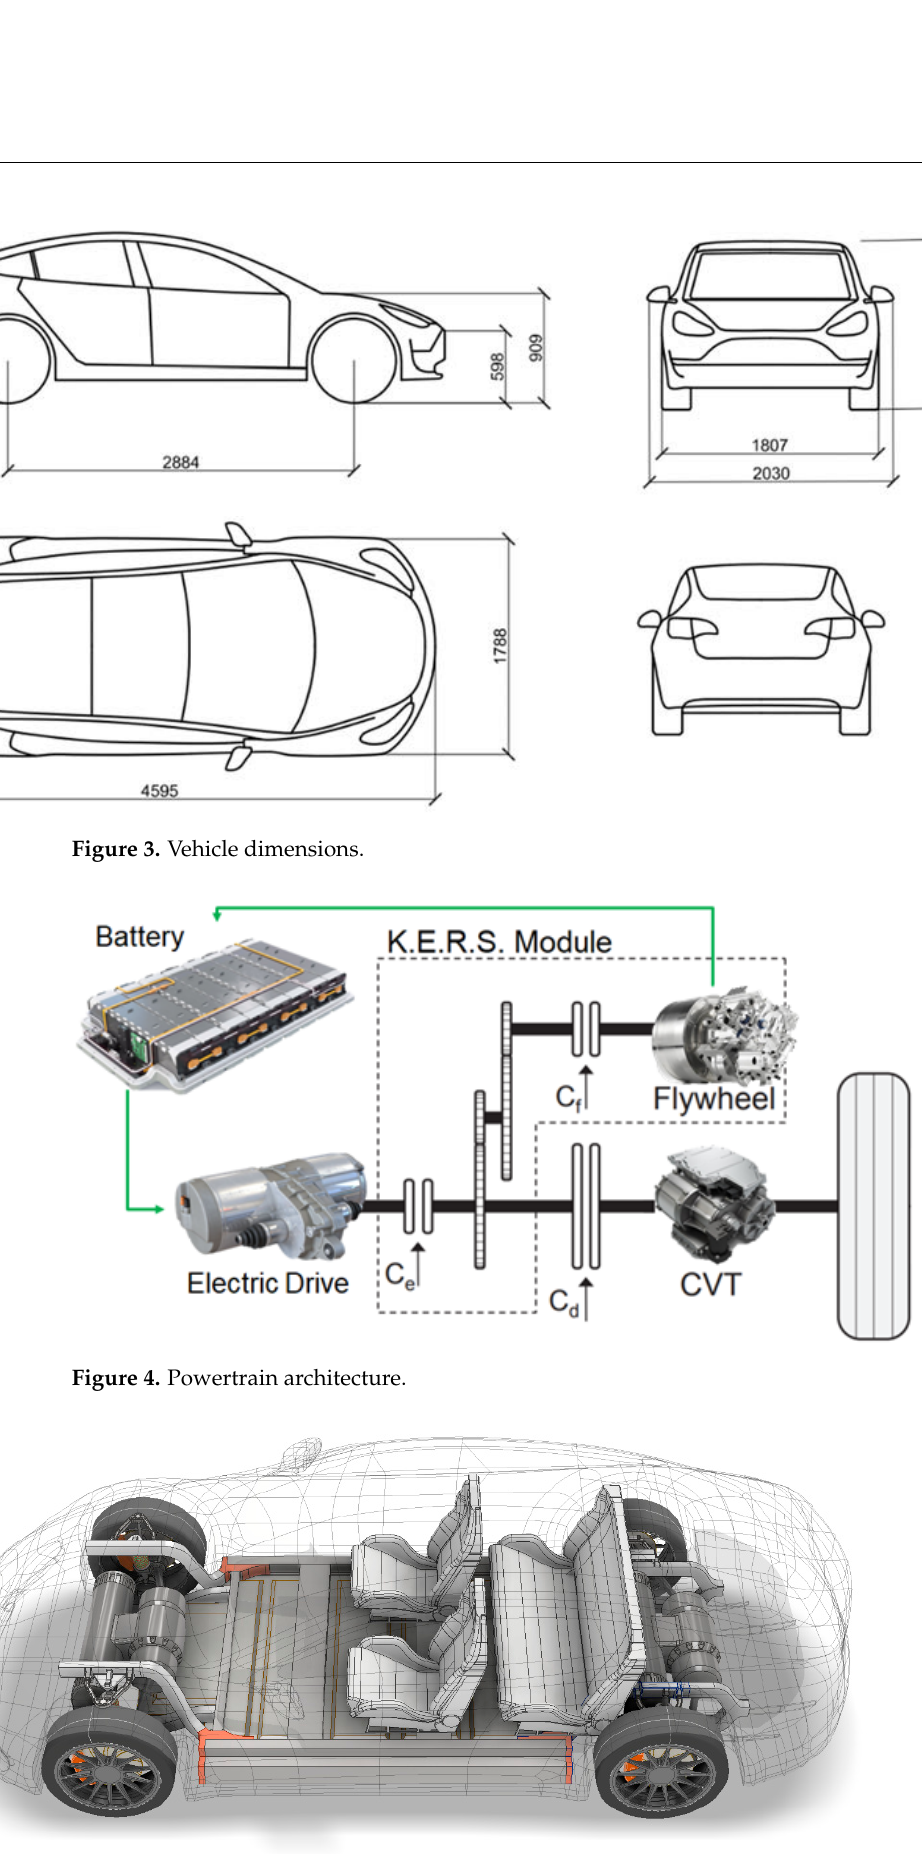
Figure 5. Vehicle 3D